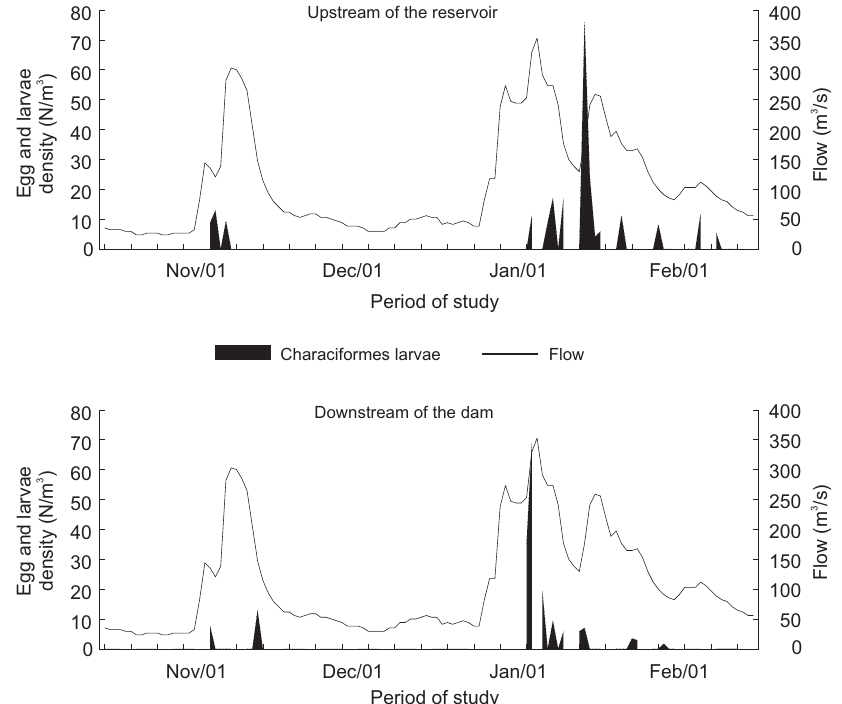
Figure 3. Density of migratory Characiformes larvae obtained upstream of the reservoir and downstream of the Santa Clara dam